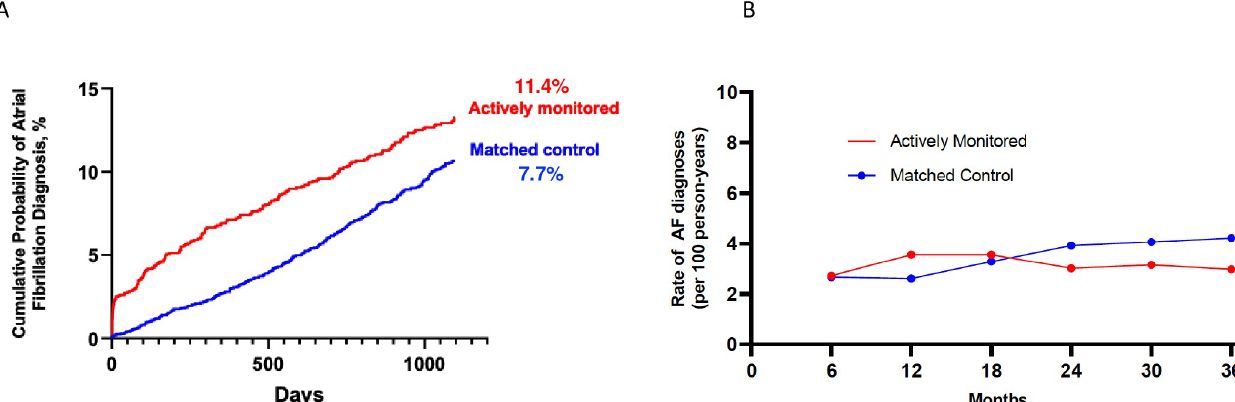
Fig 2. Atrial fibrillation diagnosis. A.) Cumulative Probability of a diagnosis of atrial fibrillation in the 3 years following the initiating of monitoring. B.) Rate of new diagnosis of atrial fibrillation in the monitored and observational cohorts after completion of active monitoring. All new diagnoses occurring annually after 6 months from the initiation of screening.